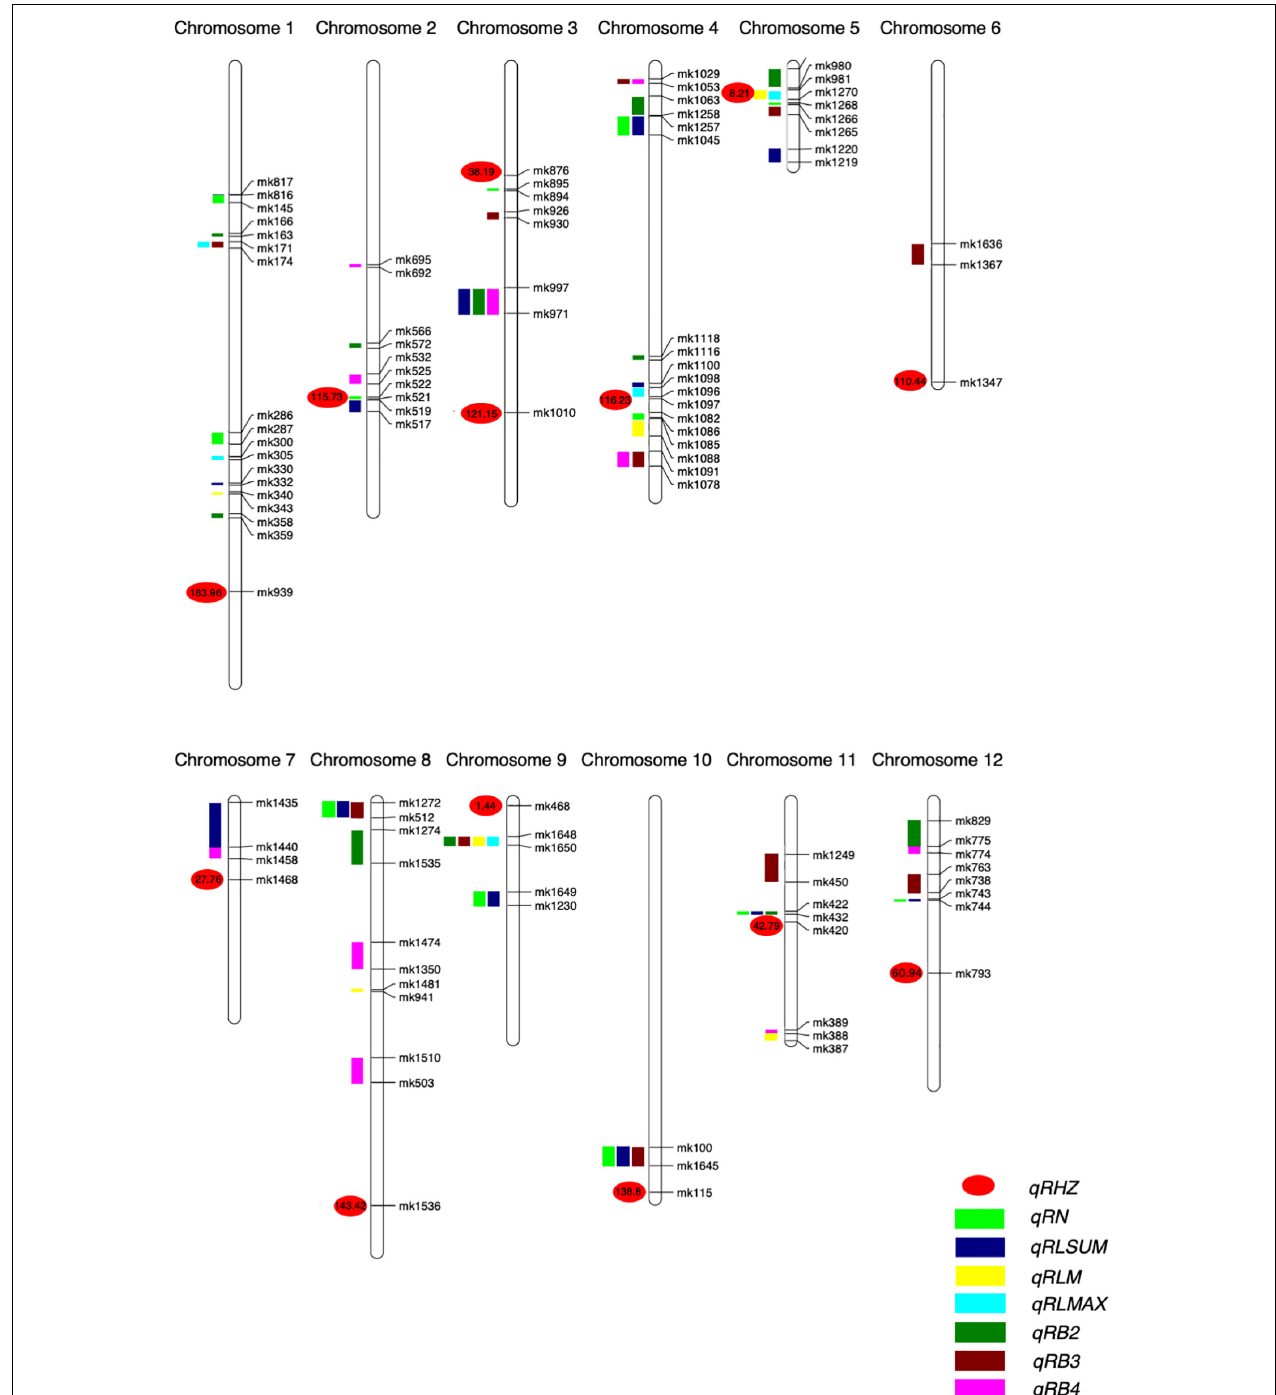
FIGURE 4 | Positions of QTLs on the genetic linkage map of the F 2 population. Numbers are genetic distances.